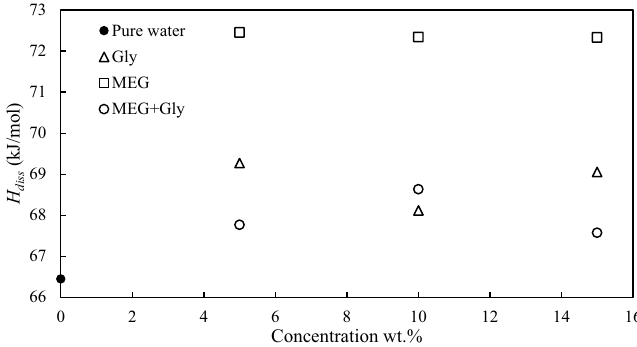
Figure 5. Comparison of enthalpy of CO 2 hydrate dissociation in the presence of 10wt.% of THIs and pure water.